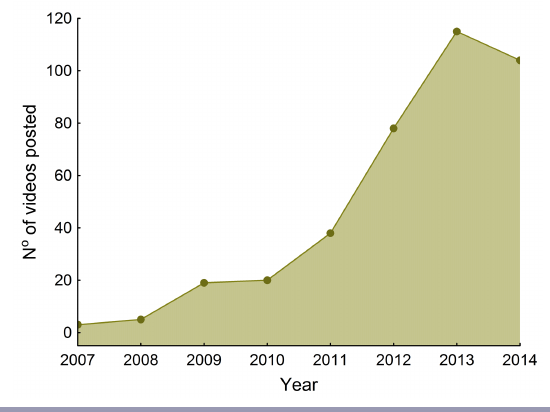
Fig. 2 . Exponential increase in the number of sport hunting videos posted on YouTube™ over the years.